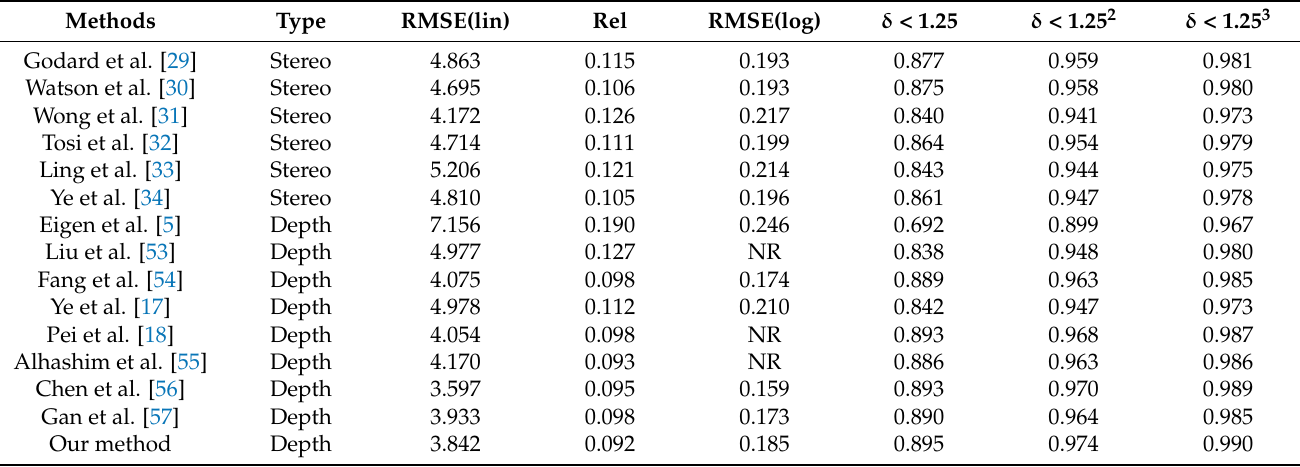
Table 2. Quantitative comparison results on KITTI